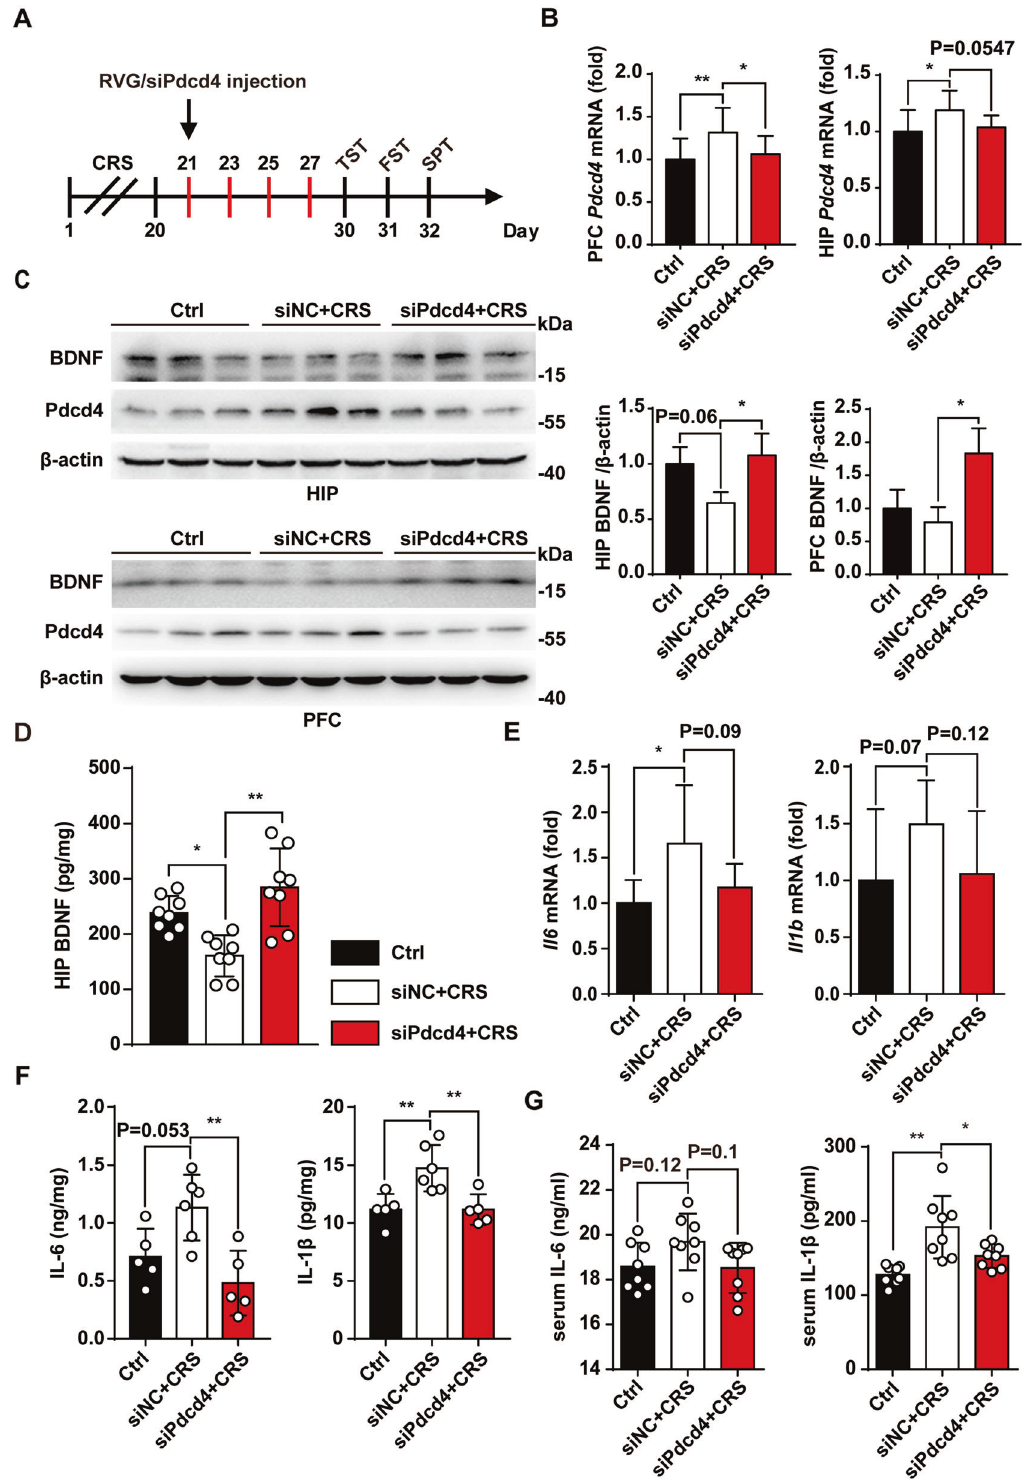
Fig. 5 RVG/siPdcd4 promotes BDNF expression and represses in fl ammation response during CRS. A Mice depression model was induced by chronic restraint stress (CRS). RVG/siPdcd4 (50 μ g, 2 mg/kg) was injected every other day from the 21st day. After the intervention of RVG/ siPdcd4, mice depression behaviors were evaluated. B Fresh brain tissues were separated and total RNA were extracted using TRIzol reagent, and the changes of Pdcd4 mRNA level in HIP and PFC were detected by RT-PCR ( n = 4 per group). C The protein changes of BDNF in the HIP and PFC were measured by western blot ( n = 3 per group). D ELISA was used to analysis the changes of BDNF in HIP ( n = 8 per group). E The changes of pro-in fl ammatory cyokines IL-6 and IL-1 β mRNA level in HIP were detected by RT-PCR (IL-6 n = 7 per group, IL-1 β n = 5 per group). F ELISA were used to analysis the changes of IL-6 and IL-1 β expression in HIP (Ctrl and siPdcd4 + CRS n = 5 per group, siNC + CRS n = 6). G ELISA were used to analysis the changes of IL-6 and IL-1 β expression in serum ( n = 8 per group). Values are indicated as mean ± SD, one-way ANOVA and multiple comparison test, * p < 0.05 ** p < 0.01. All the experiments were repeated at least three times